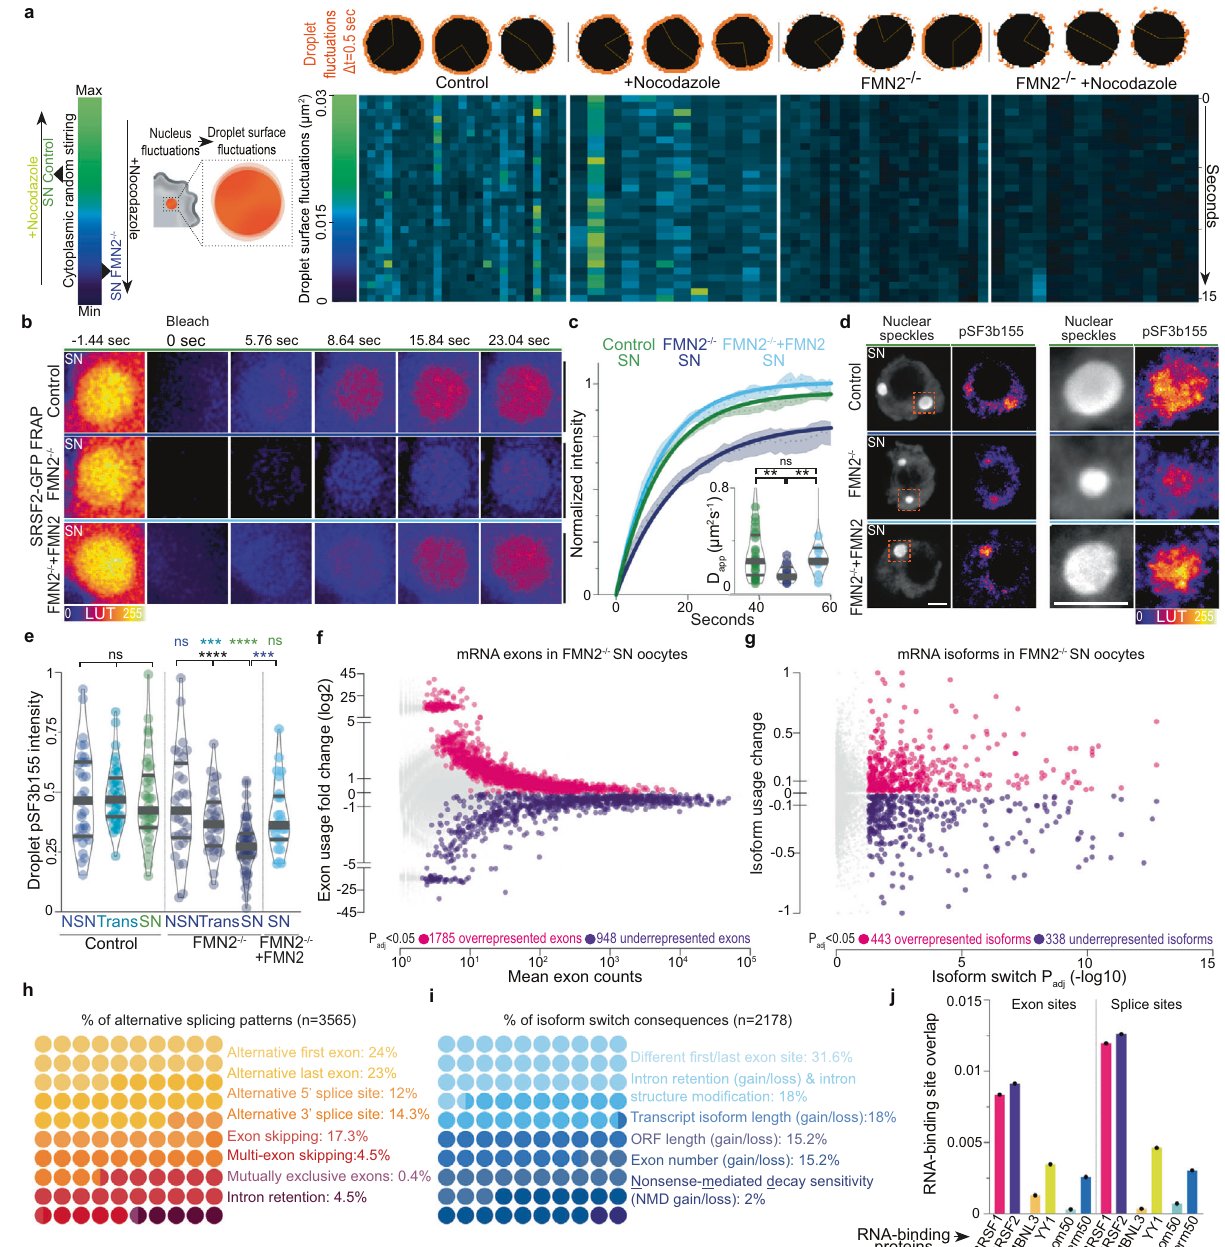
Fig. 4 | Cytoplasmic forces accelerate molecular-scale kinetics in nuclear con- densates and regulate mRNA processing. a Scheme of droplet surface fl uctua- tions as a function of cytoplasmic stirring (left); representative nuclear SRSF2-GFP droplet surface fl uctuations in orange (above) and surface fl uctuation intensity heatmaps of comparably-sized droplets (below) in SN oocytes with Control, ampli- fi ed, or disrupted cytoplasmic forces; droplet radii, 2 to 2.7 μ m; droplet number, Control=25; Nocodazole=12; FMN2 − / − =21; FMN2 − / − +Nocodazole=15. b FRAP sequences of SRSF2-GFP droplets in Control, FMN2 − / − , and FMN2 − / − +FMN2 SN oocytes. c Fluorescencerecoverycurves(mean±s.e.m.)withsimpleexponential fi ts of SRSF2-GFP droplets in Control, FMN2 − / − , and FMN2 − / − +FMN2 SN oocytes; insets, apparent diffusion coef fi cients (D app ); droplet number, Control=28, FMN2 − / − =13, FMN2 − / − +FMN2=11. d Representative co-immunostainings of nuclear speckles and phosphorylated SF3b155 (pT313) in SN Control, FMN2 − / − , and FMN2 − / − +FMN2 oocytes with magni fi cations of single droplets. e Quanti fi cations of droplet-speci fi c pT313-SF3b155 intensities in growing Control and FMN2 − / − oocytes, and in FMN2 − / − +FMN2SNoocytes;Dropletnumber,ControlNSN=34,Trans=37,SN=38, FMN2 − / − NSN=31, Trans=33, SN=56, FMN2 − / − +FMN2 SN=26. f , g Differential